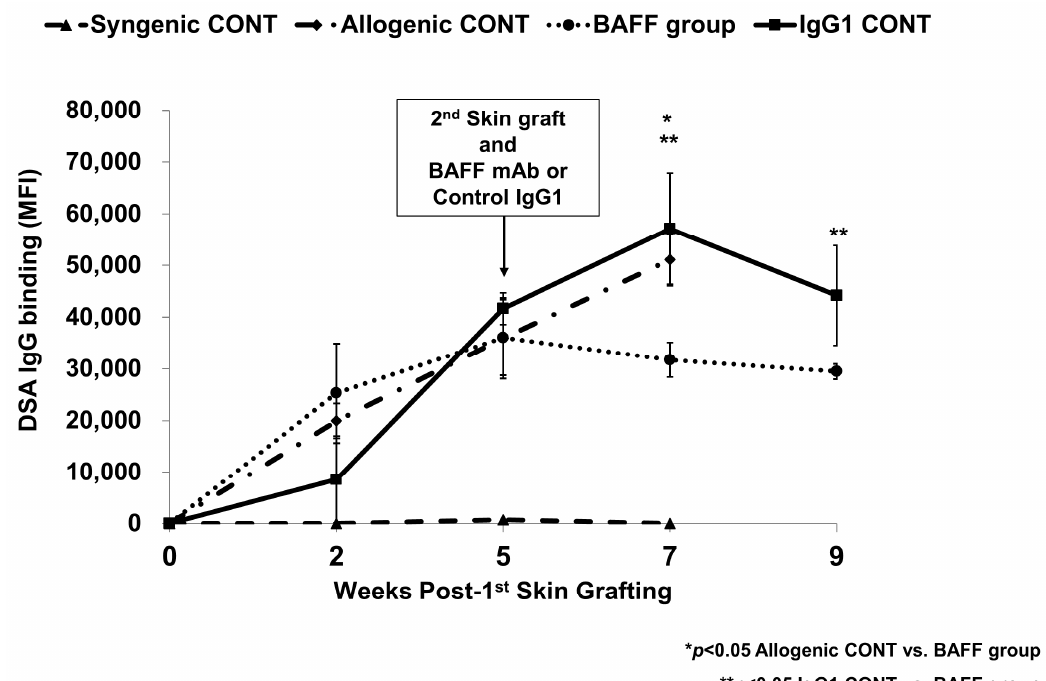
Figure 1. Mean fluorescence intensity (MFI) titers of HLA.A2-specific IgG measured at week 2, 5, 7 and 9. Error bars represent 2 standard errors (SE).